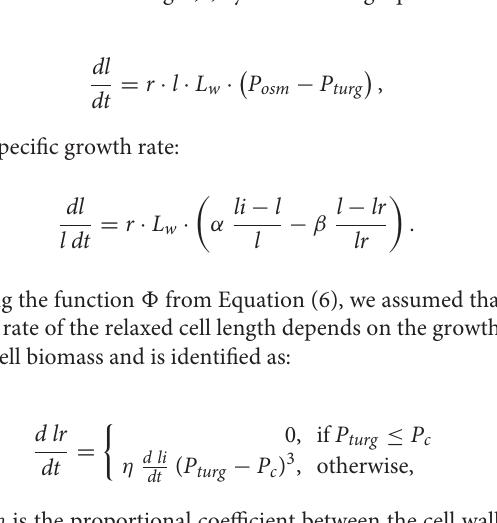
Frontiers in Plant Science |